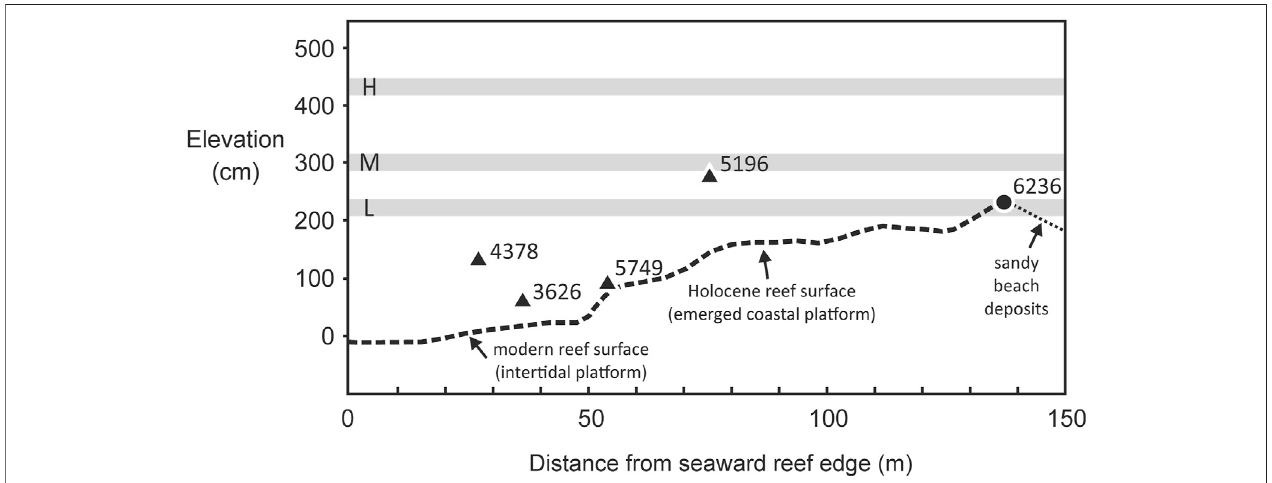
FIGURE 4 | Cross section of surface topography across the coastal limestone platform (Dahu Reef) in Wen Cuen bay. Redrawn and adapted from Inoue et al. (2011). The transect location is shown in Figure 3 . Black circles or triangles represent elevations of fossil corals sampled by Inoue et al. (2011) from the reef surface at both the study site and elsewhere in eastern Ludao. Calibrated ages (cal yr BP) from radiocarbon dating are indicated. Uplifted Holocene reef terraces at higher levels, exposed in various locations around Ludao, are shown asgray horizontal bars (lower (L), middle (M), and higher (H) marine terraces, from level-and-staff elevations relative to mean sea level